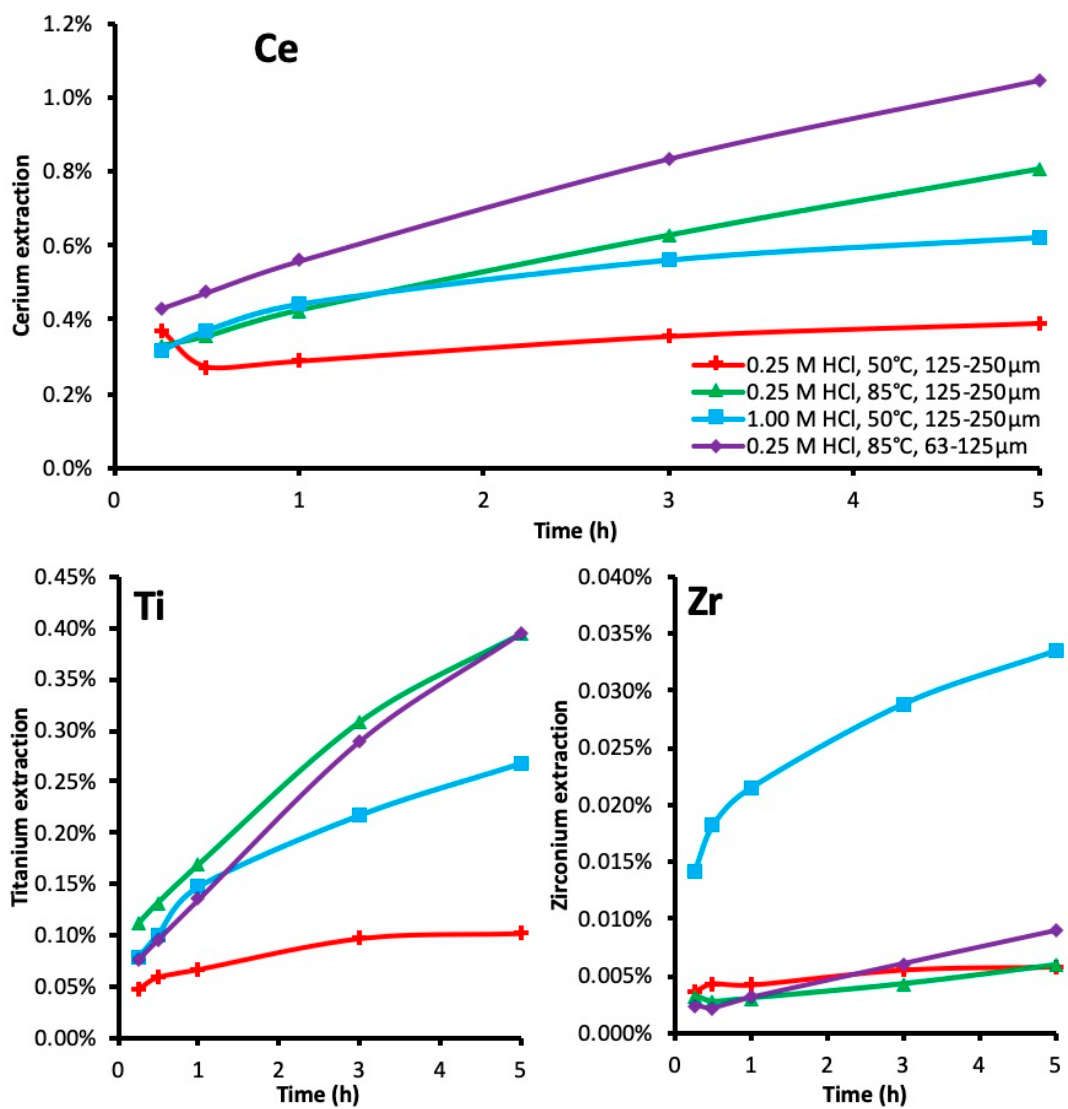
Figure 6. Leaching kinetics under various conditions in hydrochloric acid media.